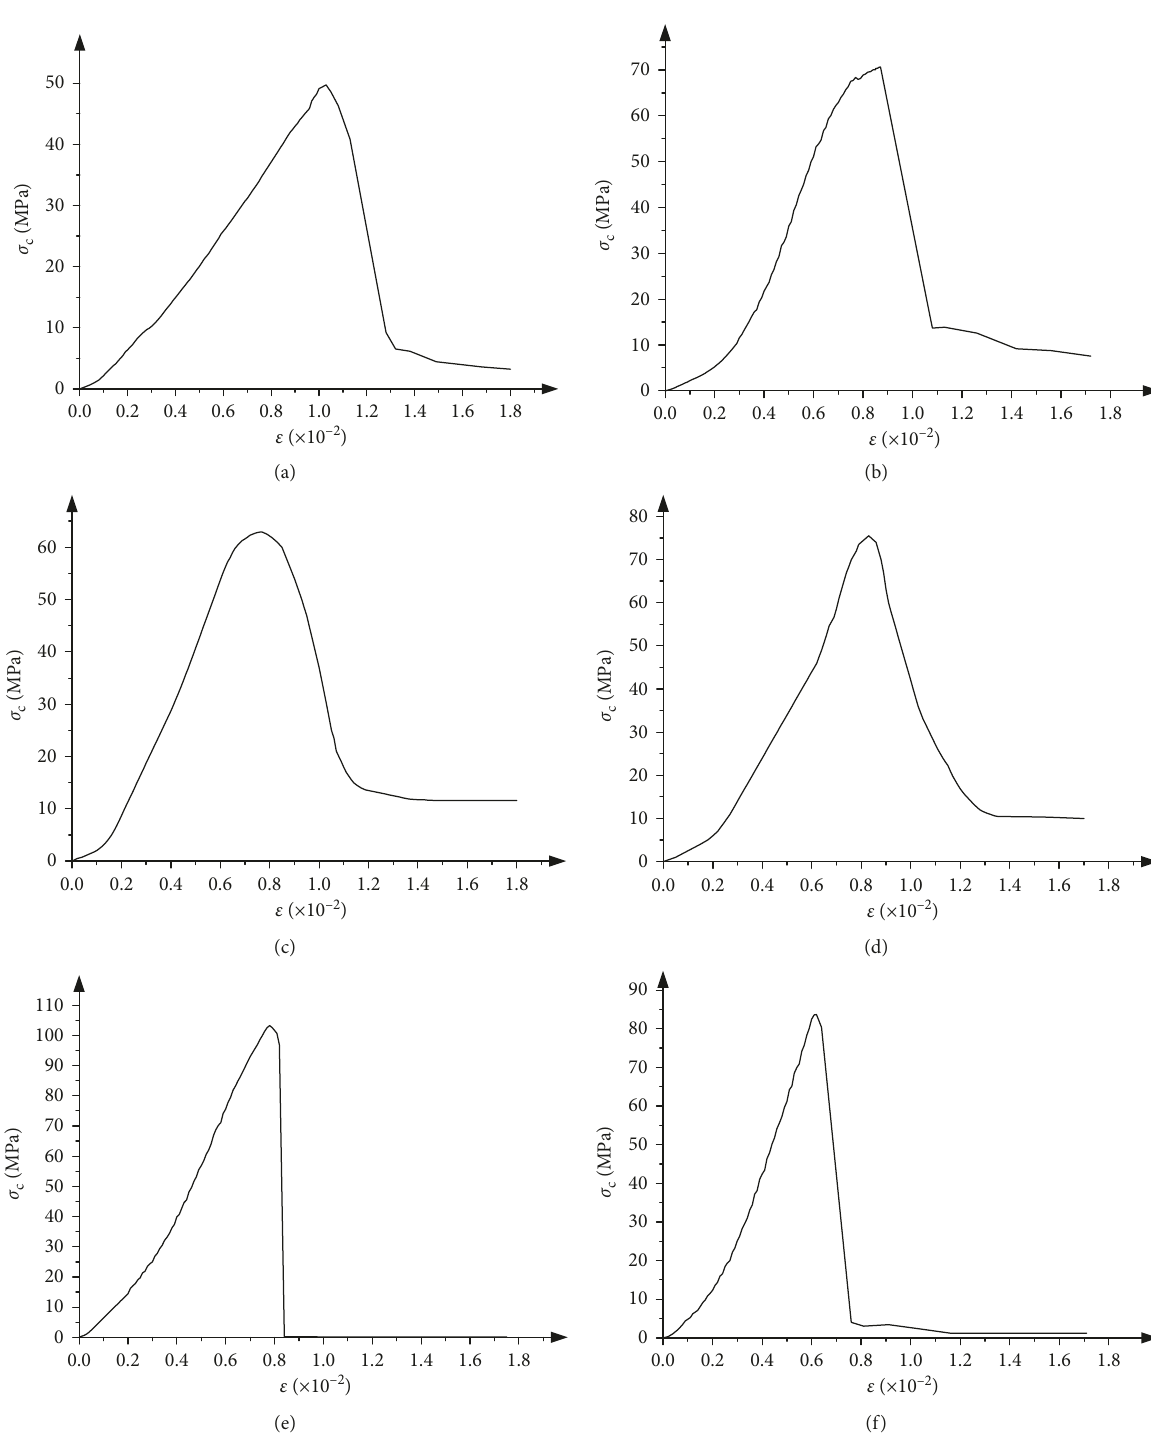
Figure 10: Strain-stress curves of rock masses in Zhazixi Antimony Mine. (a) Slate. (b) Tuffaceous slate. (c) Quartz sandstone. (d) Tuffaceous sandstone. (e) Dense massive stibnite. (f) Disseminated